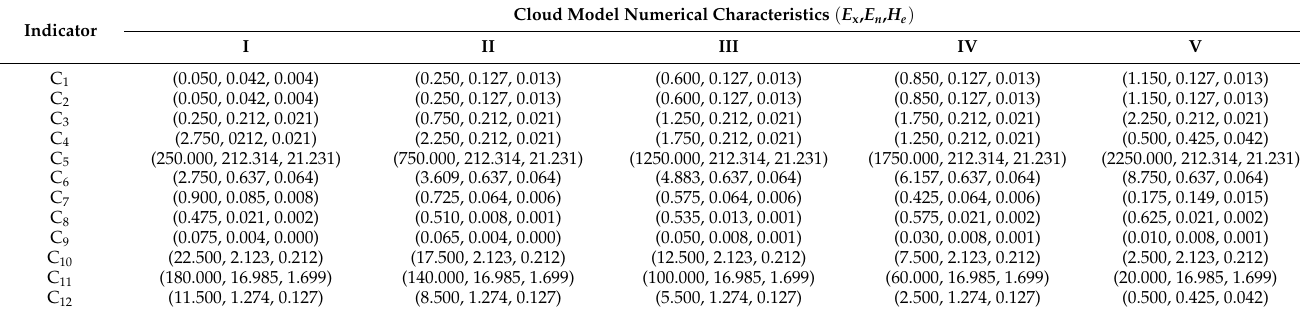
Table 5. Indicators’ numerical